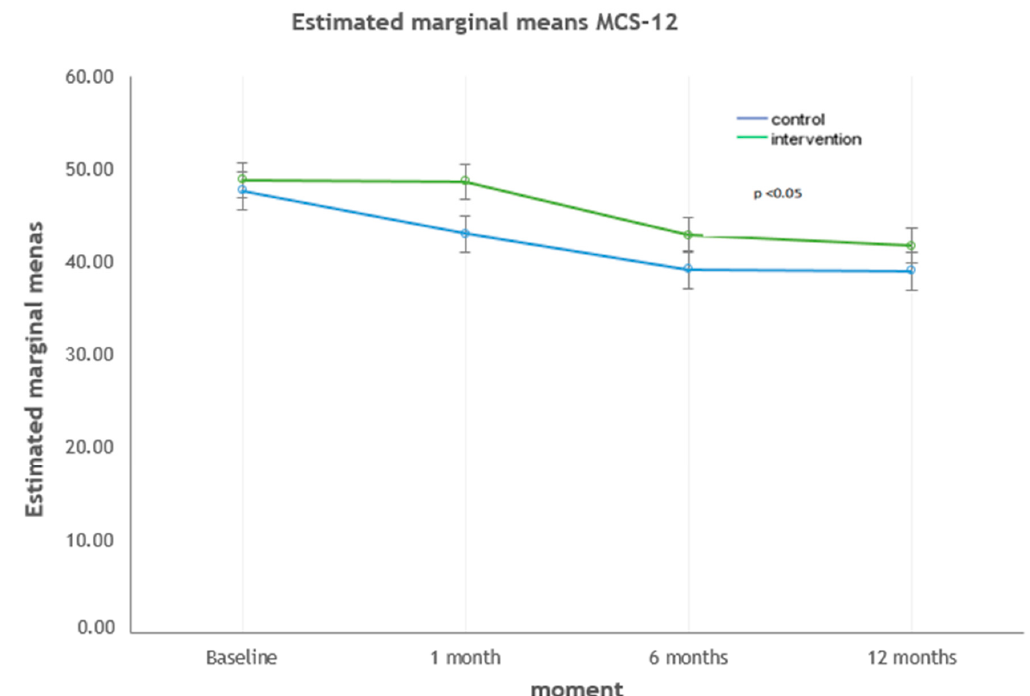
Figure 2. Evolution of the MCS-12 summary dimension: intervention vs. control group.